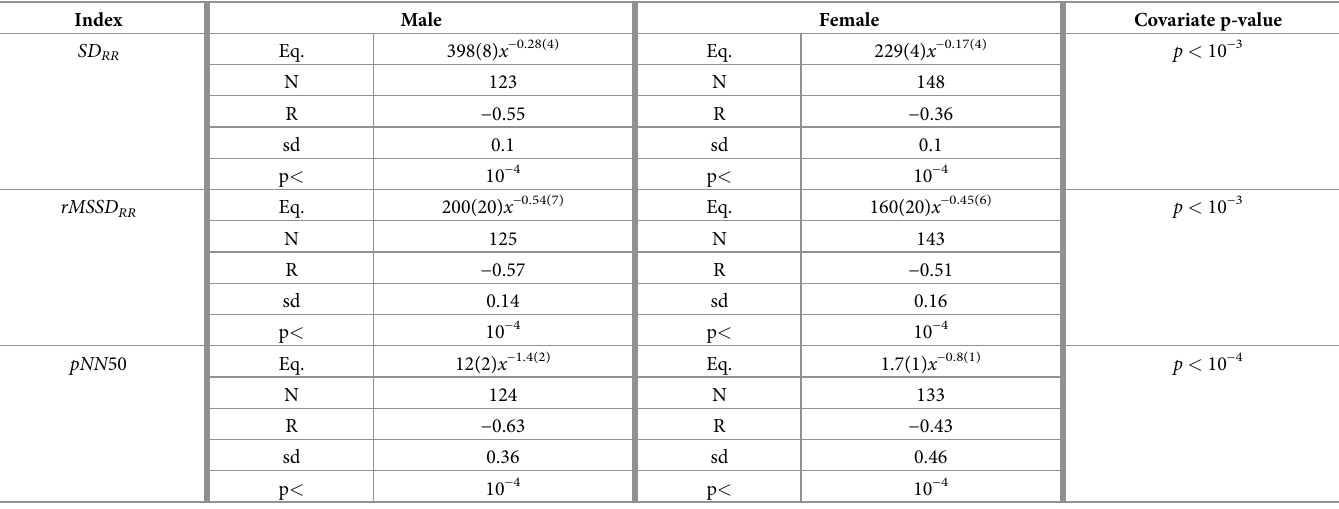
Table 9. Power law adjustments by gender for participants over 12 years old.